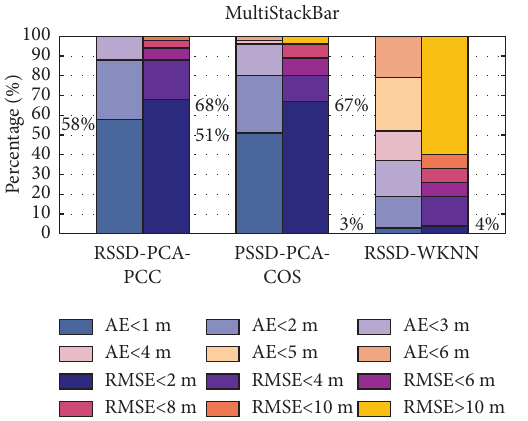
Figure 6: Percentage comparisons of location errors among RSSD-WKNN, RSSD-PCA-COS, and proposed RSSD-PCA-PCC with 2m grid distance, 4 APs, and K � 4.